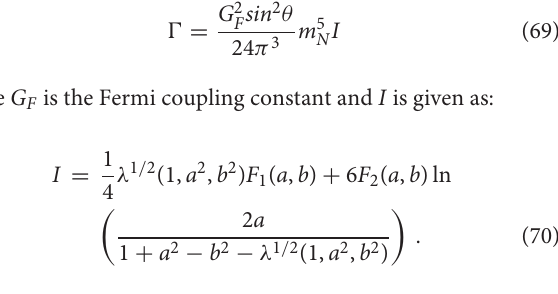
0.3 (Blue), 0.4 < sin θ ≤